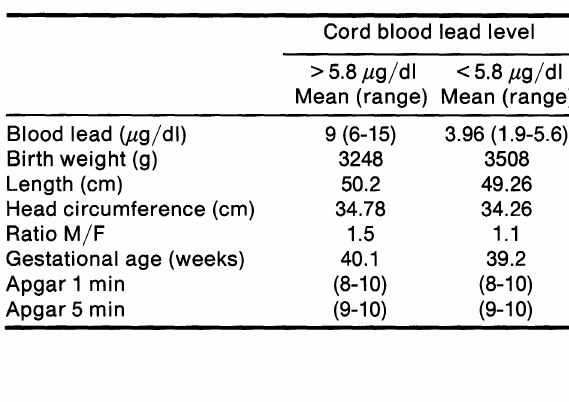
TABLE I. Comparative analysis of infants in the study